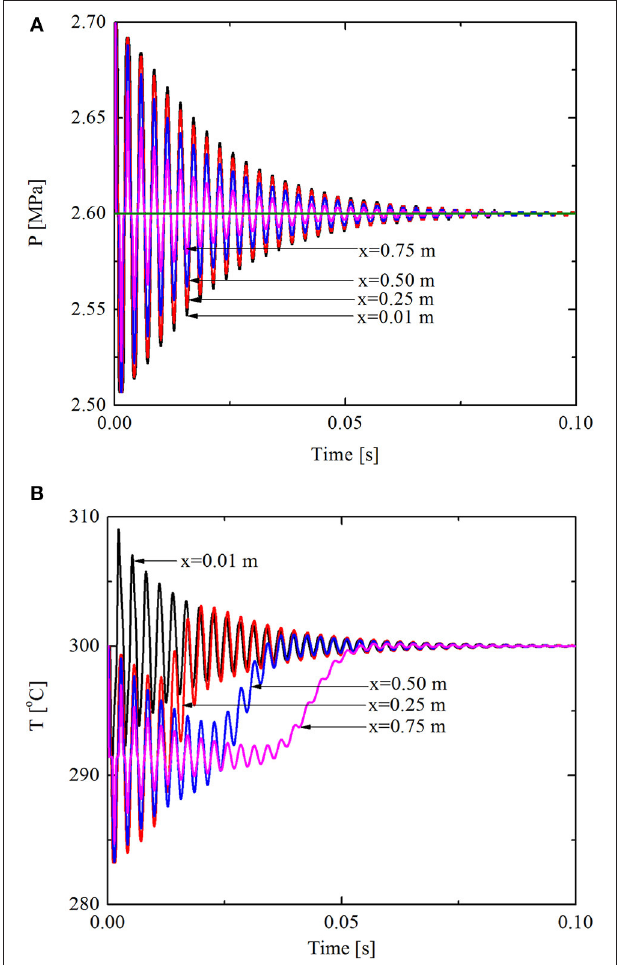
FIGURE 6 | Responses of the hybrid semi-implicit under outlet pressure transient. (A) Pressure responses. (B) Temperature responses.